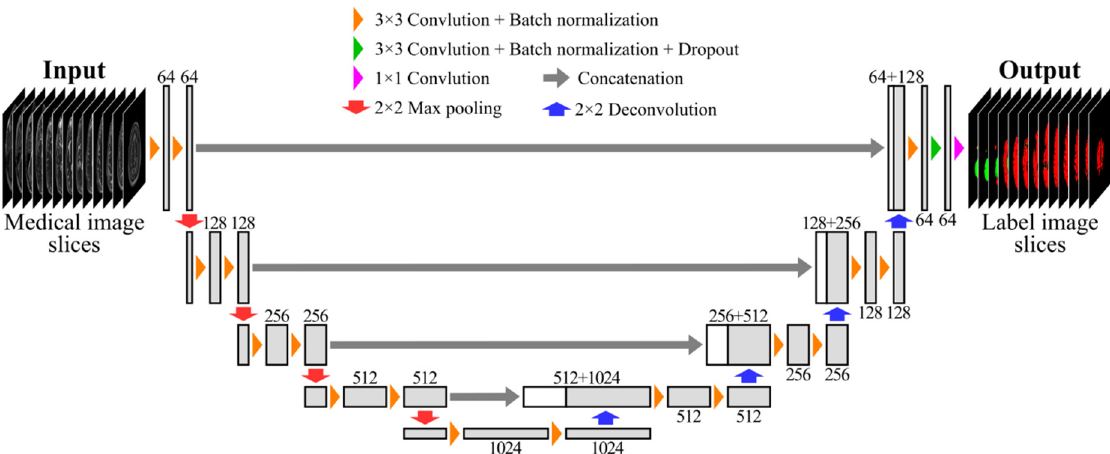
Figure 2. FCN architecture. Each box represents a set of feature maps. The number of feature maps is denoted on the top or bottom of each box.